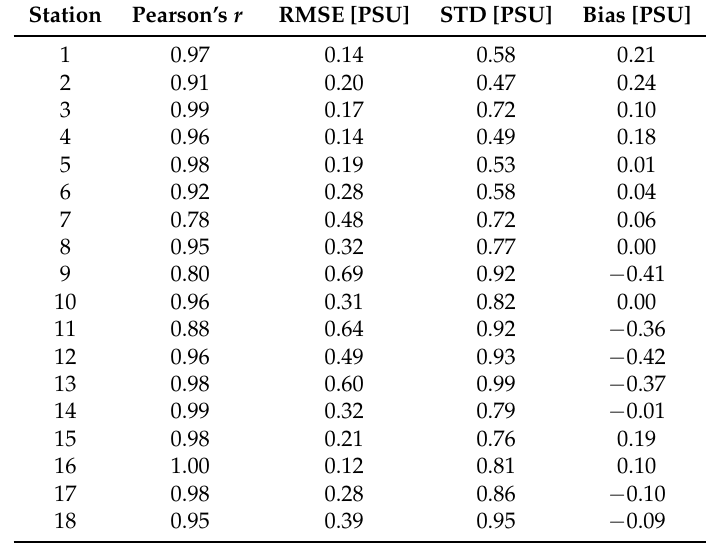
Table 8. Statistical comparison between model results and in situ measured water salinity in vertical profiles (s/y